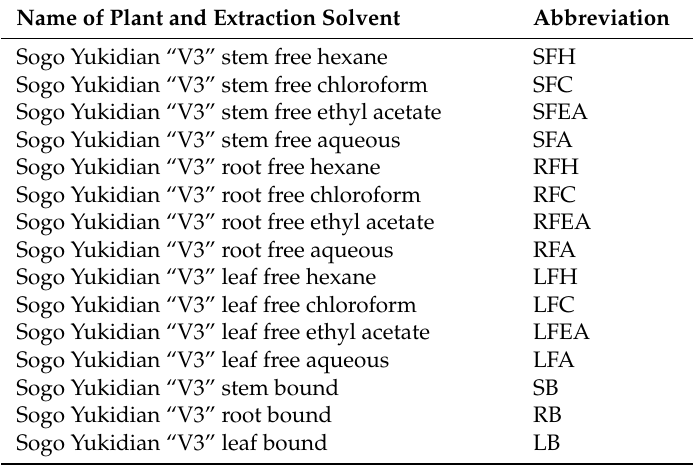
Table 1. Names and abbreviations of plant extracts with different